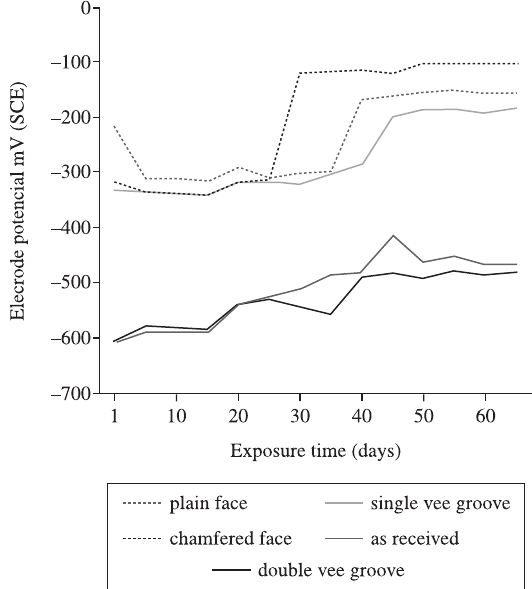
Figure 1. Plot of Electrode Potential vs. Exposure Time of Austenitic Stainless Steel Welded at various Weld Geometry.